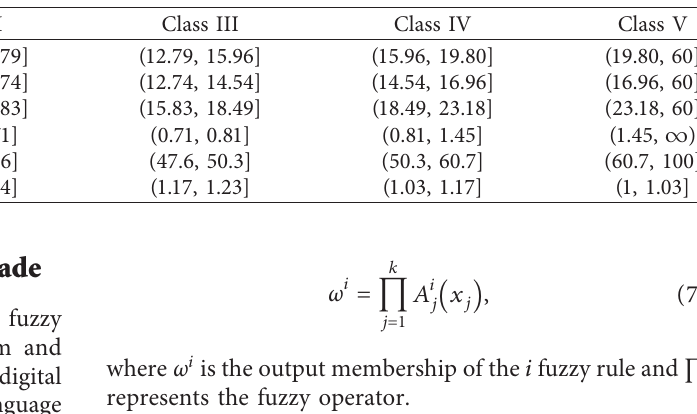
Table 1: Classification standard of bus-line